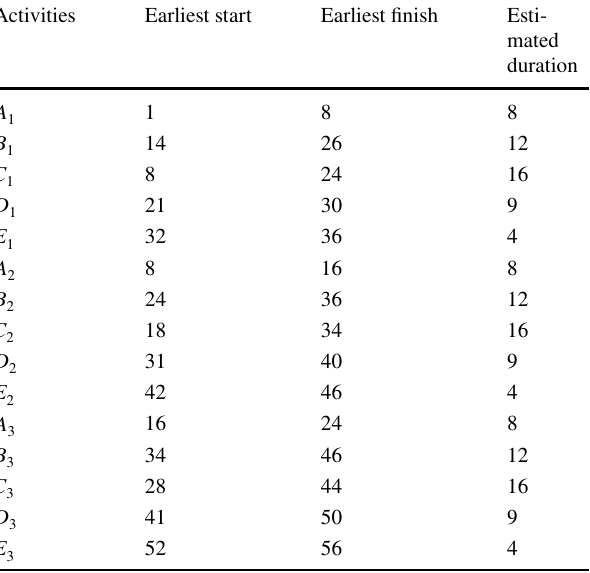
Table 2 Appropriate time calculations for each activity